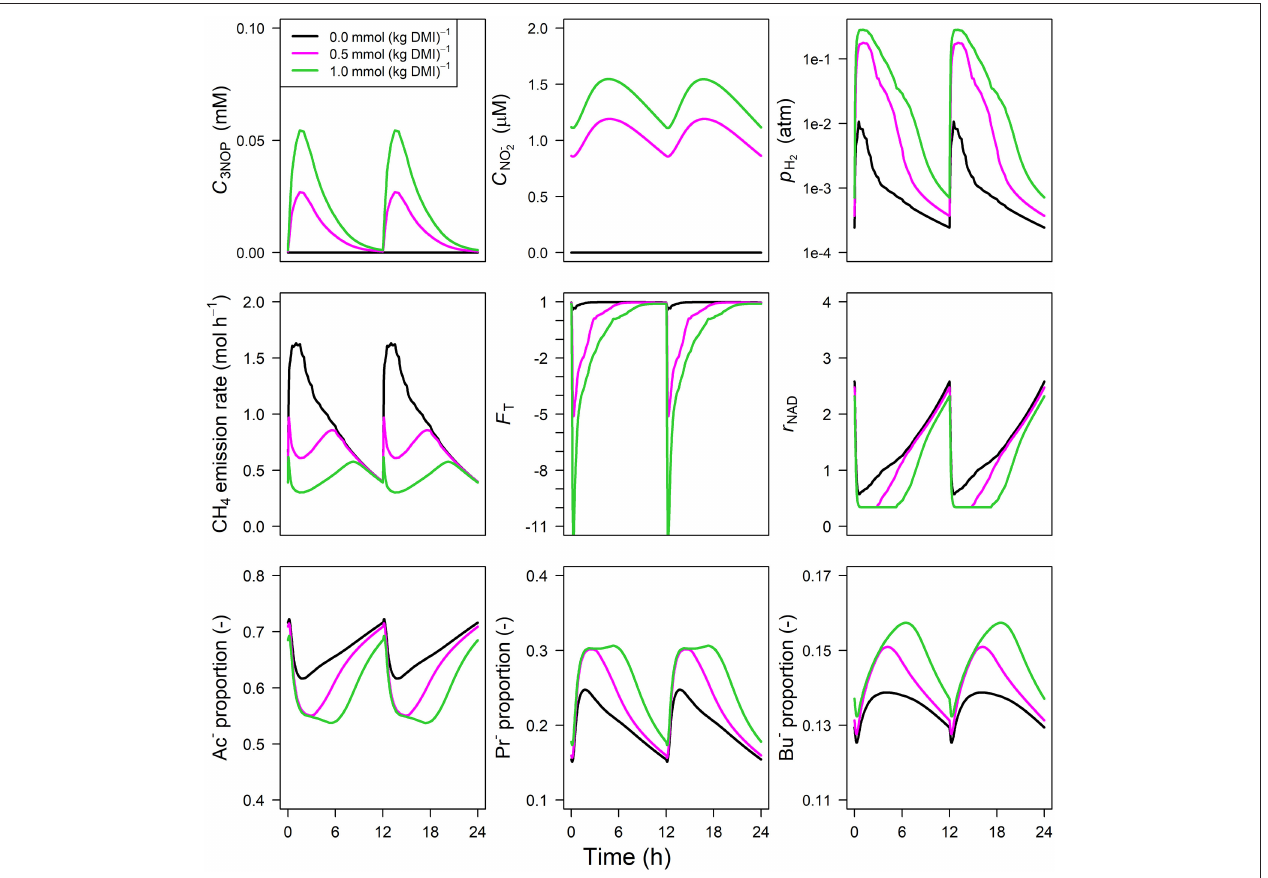
FIGURE 4 | Solutions of the 3-NOP dynamic model with NO – 2 representation for 3-NOP concentration [mM], NO – 2 concentration [ µ M], rumen headspace p H CH 4 emission rates [mol · h − 1 ], thermodynamic potential factor ( F T ; [–]), NAD + to NADH ratio ( r NAD ), acetate proportion (Ac – ), propionate proportion (Pr – ), and butyrate proportion (Bu –